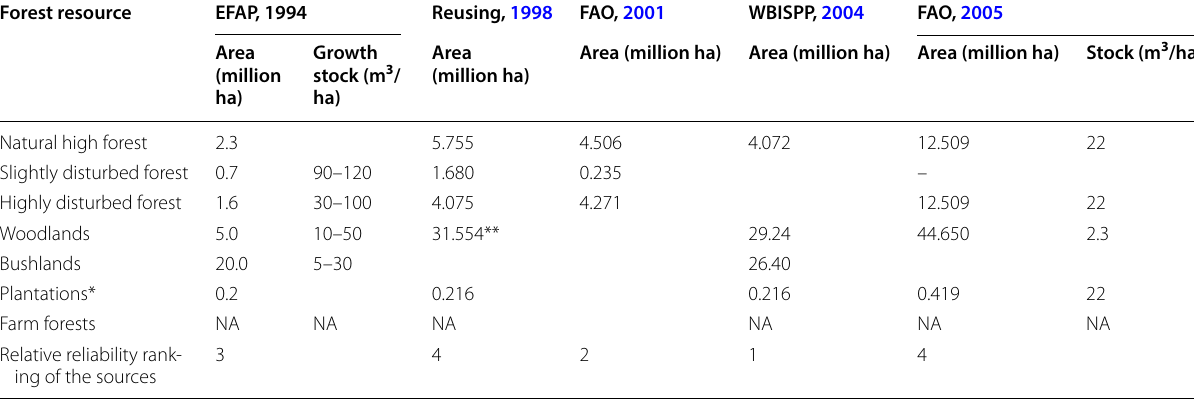
Source: Lemenih and Woldemariam (2010) * FAO statistics on plantations (only commercial), ** woodlands and bushlands combined; NA